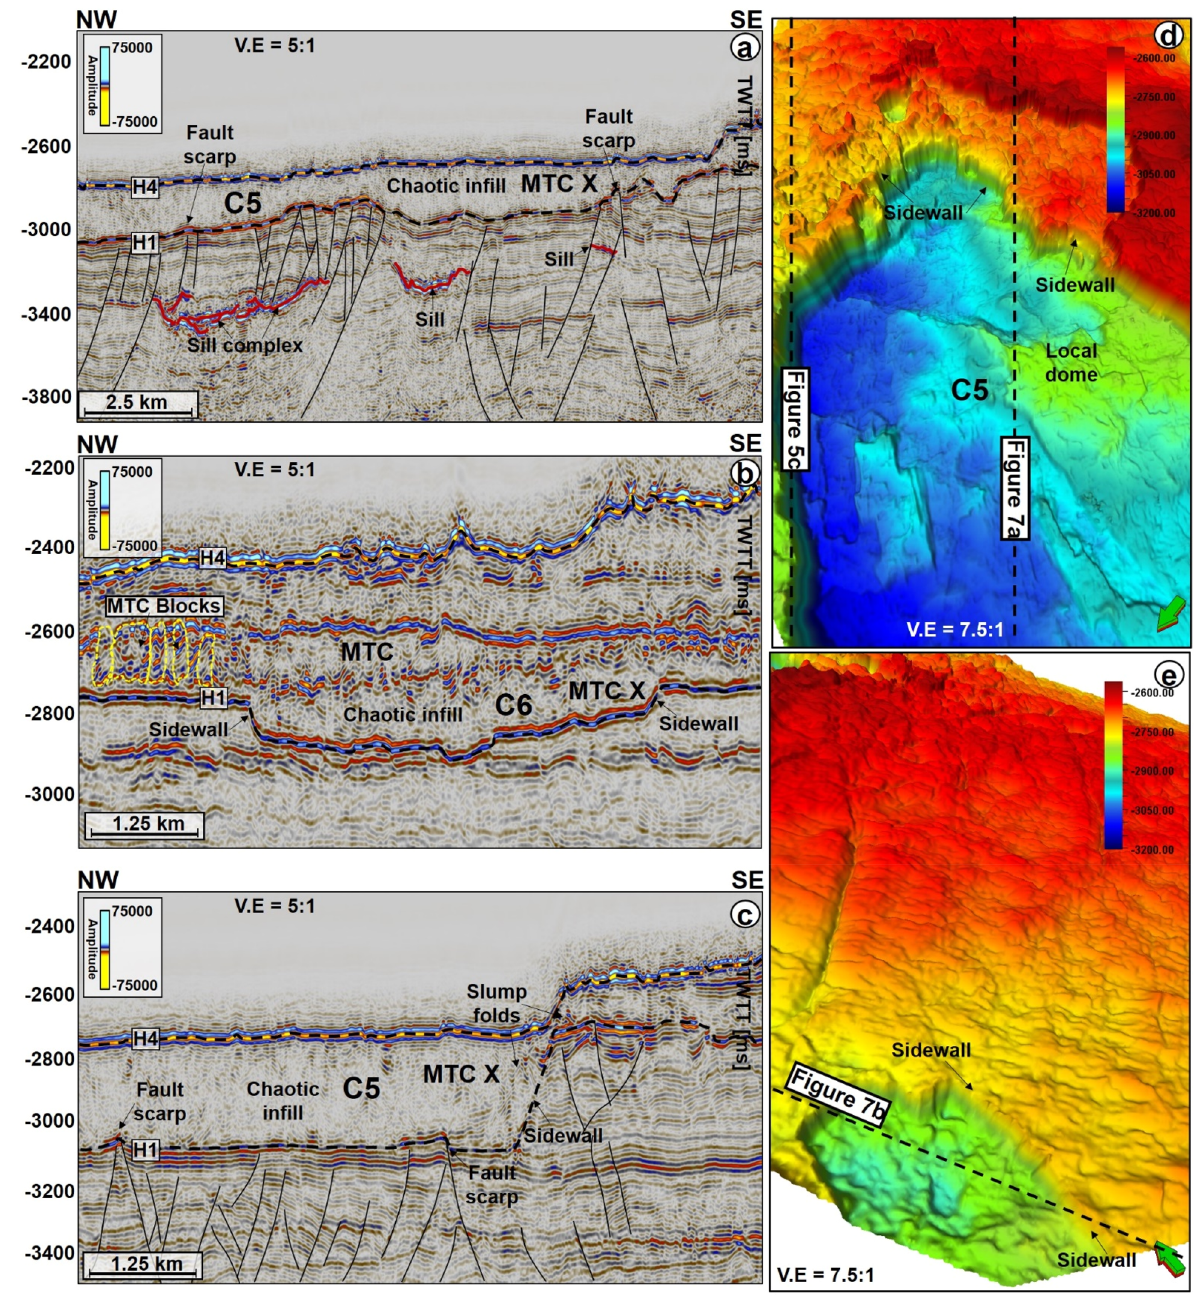
Figure 7. ( a – c ) Seismic profiles showing the infill types within C5 and C6 in the Solsikke area. Magmatic sills or faults are found in the places where the BSZ is arcuate or uplifted. N.B: Uninterpreted seismic profiles are provided in the appendix. ( d , e ) 3D perspective of the location of the seismic profiles in ( a , c ) and the differences in the architecture of the BSZ of MTC X. In addition, C6 is capped by a MTC comprising a heterogenous mixture of slide (or rafted) blocks and chaotic